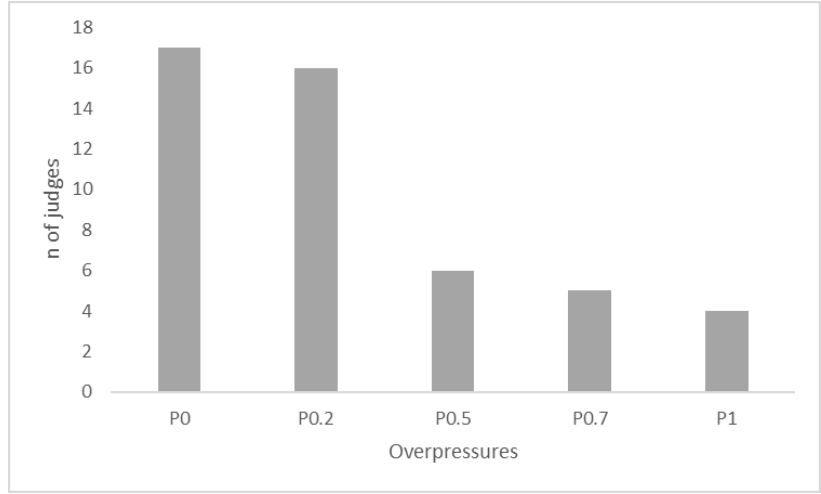
Figure 3. Frequency distribution of preferences as a function of fermentation pressure.